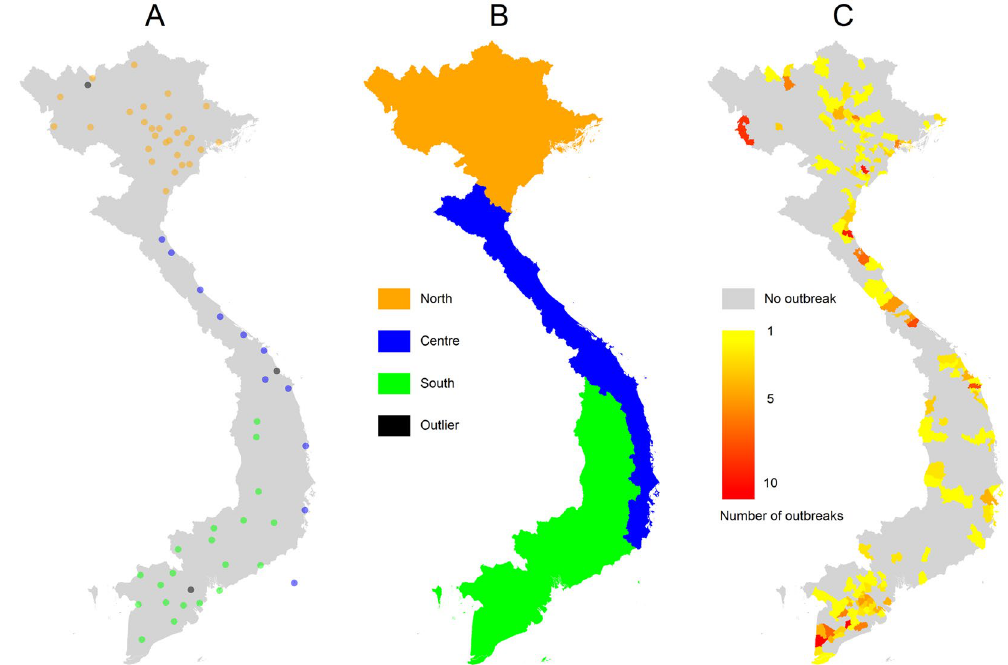
Figure 1. Selection of the three climatic regions of Vietnam. ( A ) Spatial location of weather stations belonging to each of the three identified clusters, differentiated by colour. ( B ) The three climatic regions. ( C ) Spatial location of AIOs reported in the domestic poultry of Vietnam from 2008 to 2015. Maps were produced using R 3.2.0 (http://www.R-project.org/). Administrative boundaries were drawn using GADM database of Global Administrative Areas, version 2.0